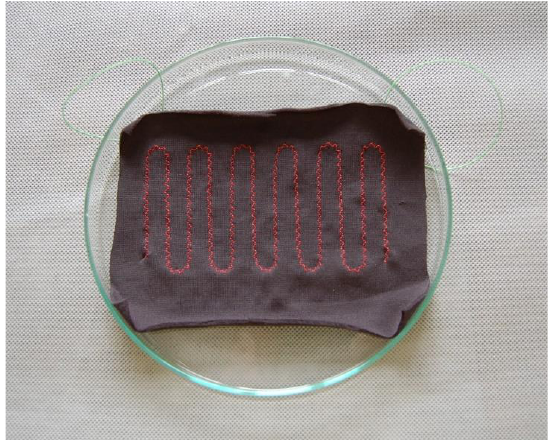
Figure 5. Photograph of the heating insert (variant A) exposed to artificial sweat.